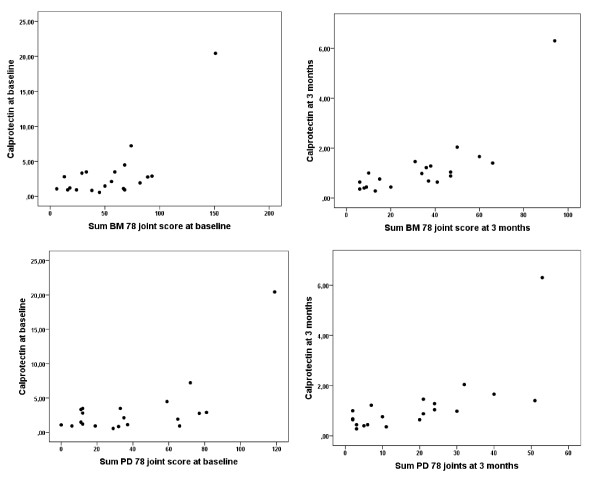
Scatterplots of calprotectin levels with corresponding sum B-mode (BM) or power Doppler (PD) scores. The scatterplots illustrate the distribution of the calprotectin levels with the corresponding total sum B-mode (BM) or power Doppler (PD) scores at baseline and at three months examination.